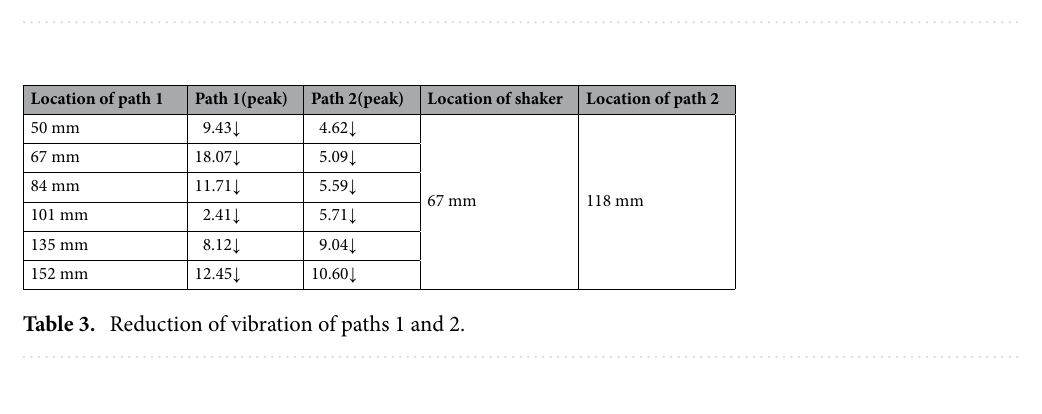
Figure 24. Compared magnitude with displacement for sinusoid signals at path 2. Key: blue line = control force; red line = vibration reduction effect.